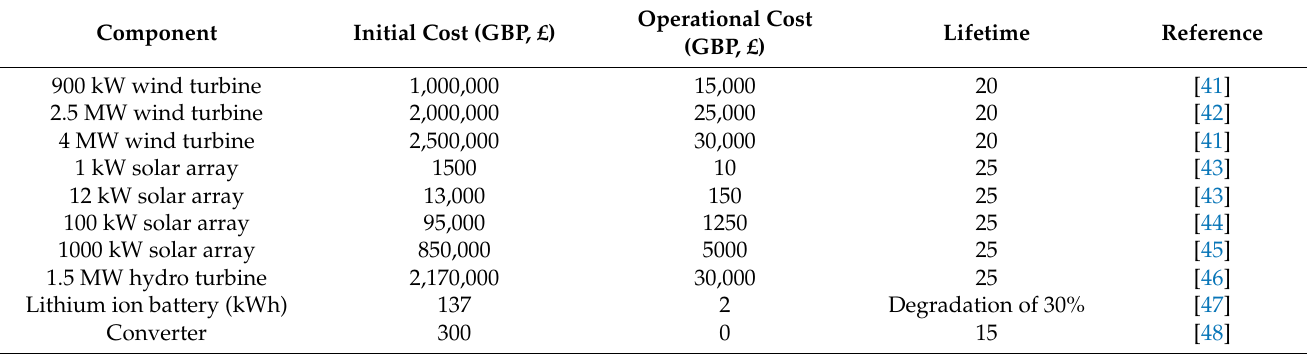
Table 7. Component sizes and